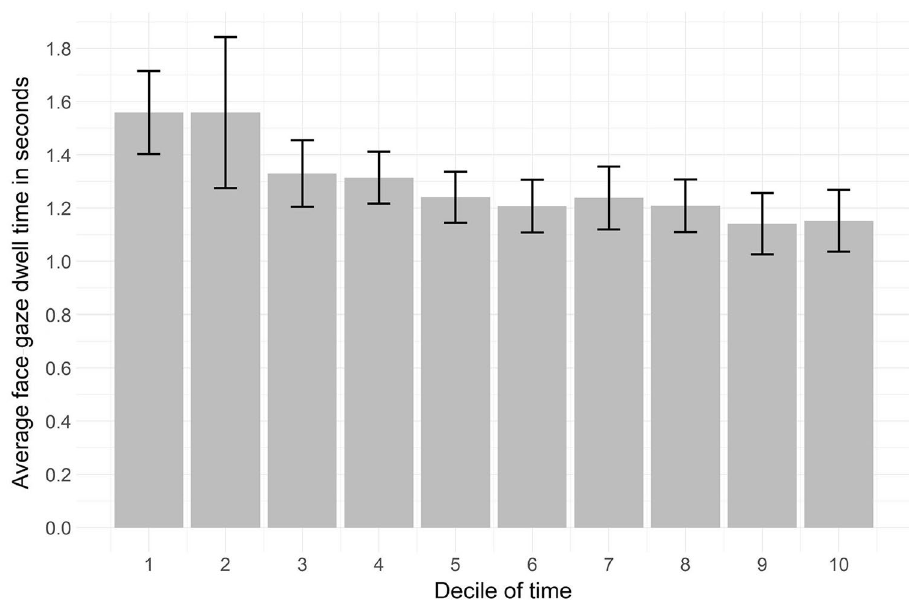
Figure 3. Development of the physicians’ face gaze dwell time in seconds throughout the consultations per decile of